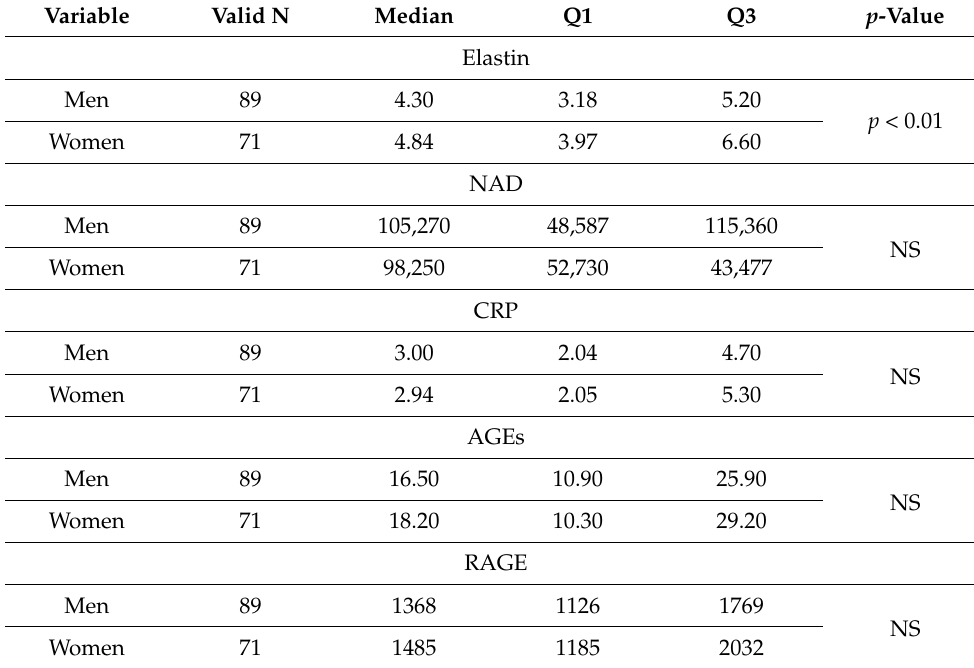
Table 4. Sex differences expressed as medians and interquartile ranges of (Q1,Q3).